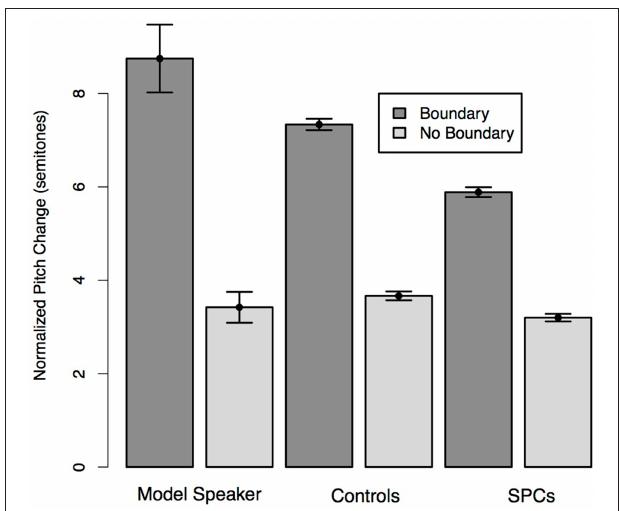
FIGURE 7 | Normalized pitch variation of words preceding hypothesized boundary locations and non-boundary locations in the Relative Clause sentences as produced by the Model Speaker, Controls, and SPCs. Error bars represent standard errors.